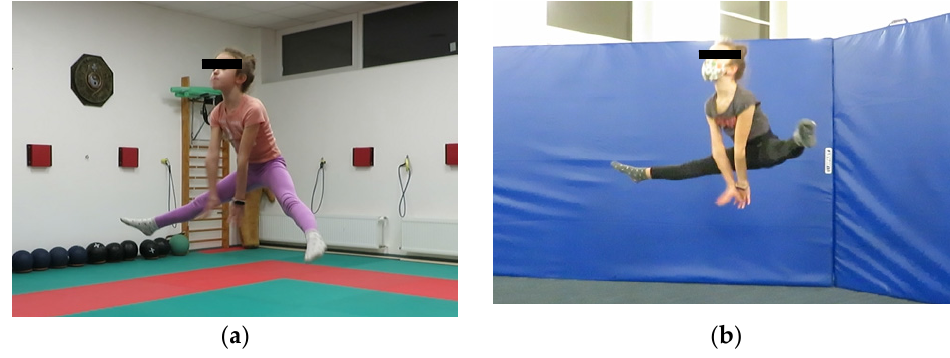
Figure 3. The biggest progress in culmination in IP1: ( a ) pretest; ( b ) posttest.